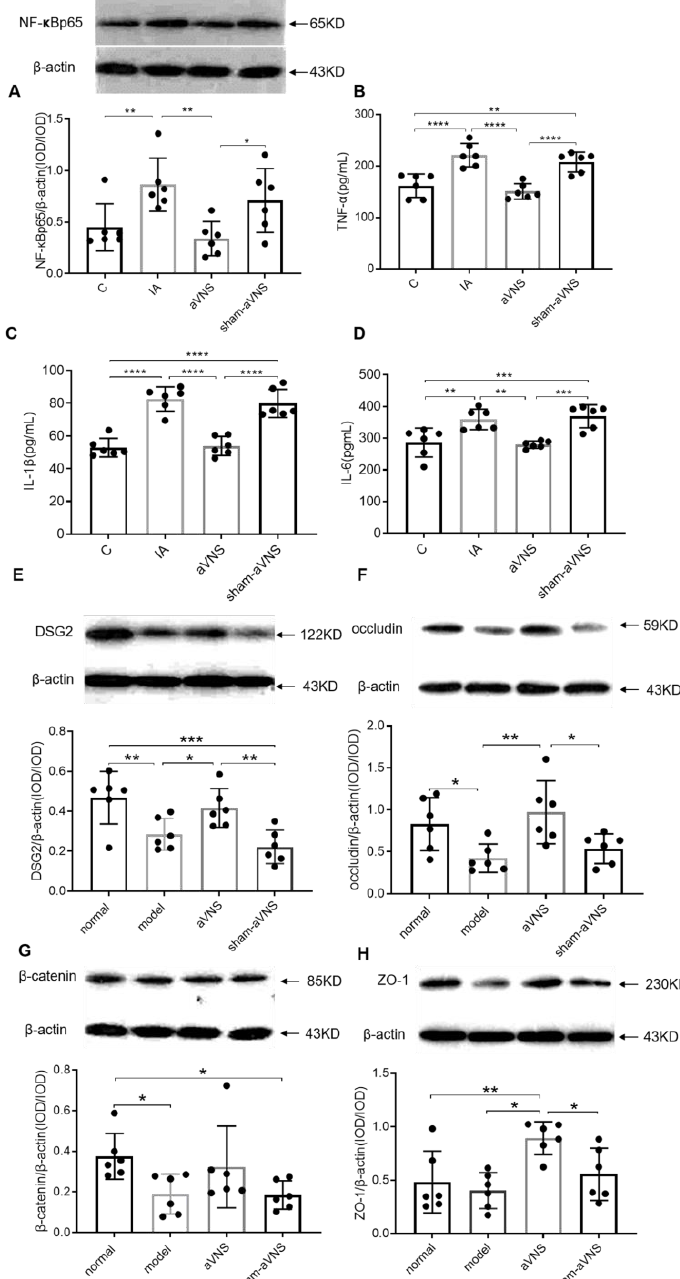
Figure 5. The anti-inflammatory and mucosal integrity mechanism of the intervention. ( A ) Level of duodenal NF- κ Bp65 after two weeks of intervention in all groups. ( B – D ) Release of serum TNF- α , IL-1 β and IL-6 after two weeks of intervention in all groups. ( E – H ) Expressions of duodenal l proteins DSG2, occludin, β -catenin and ZO-1. One-way ANOVA was used, and the LSD method was used for post hoc tests for all. * p < 0.05, ** p < 0.01, *** p < 0.001, **** p < 0.0001. NF- κ Bp65: nuclear factor kappa Bp65.TNF- α : tumor necrosis factor α .IL-1 β : interleukin 1 β . IL-6: interleukin 6. DSG2: desmoglein2. ZO-1: zonula occluden. C: control group; IA: IA-treated group. n = 6 per group. Data were presented as means ± standard deviation.